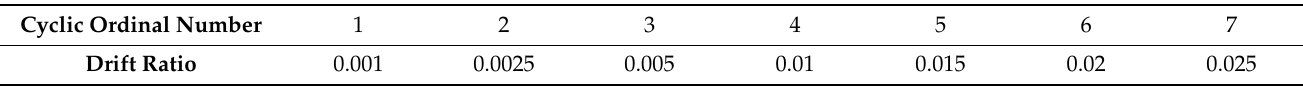
Table 7. Cyclic loading